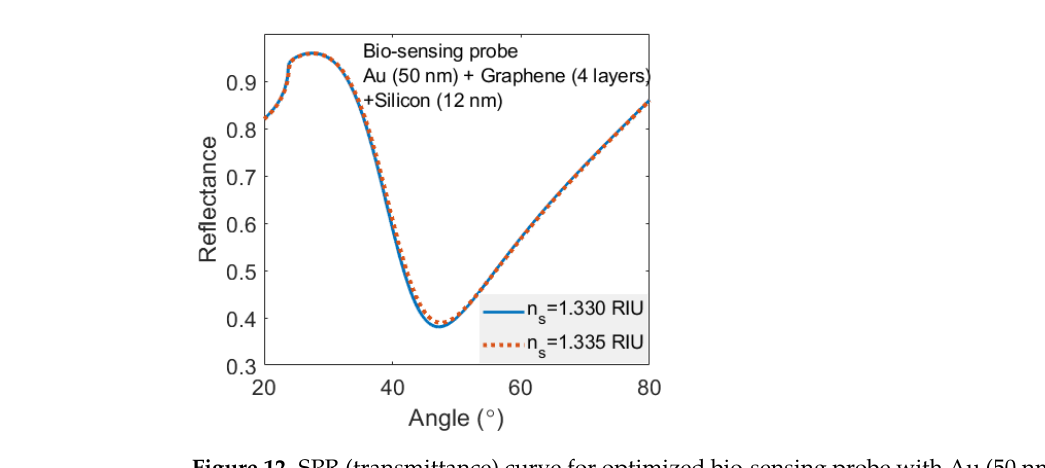
Figure 12. SPR (transmittance) curve for optimized bio-sensing probe with Au (50 nm)/graphene (four layers)/silicon (12 nm).